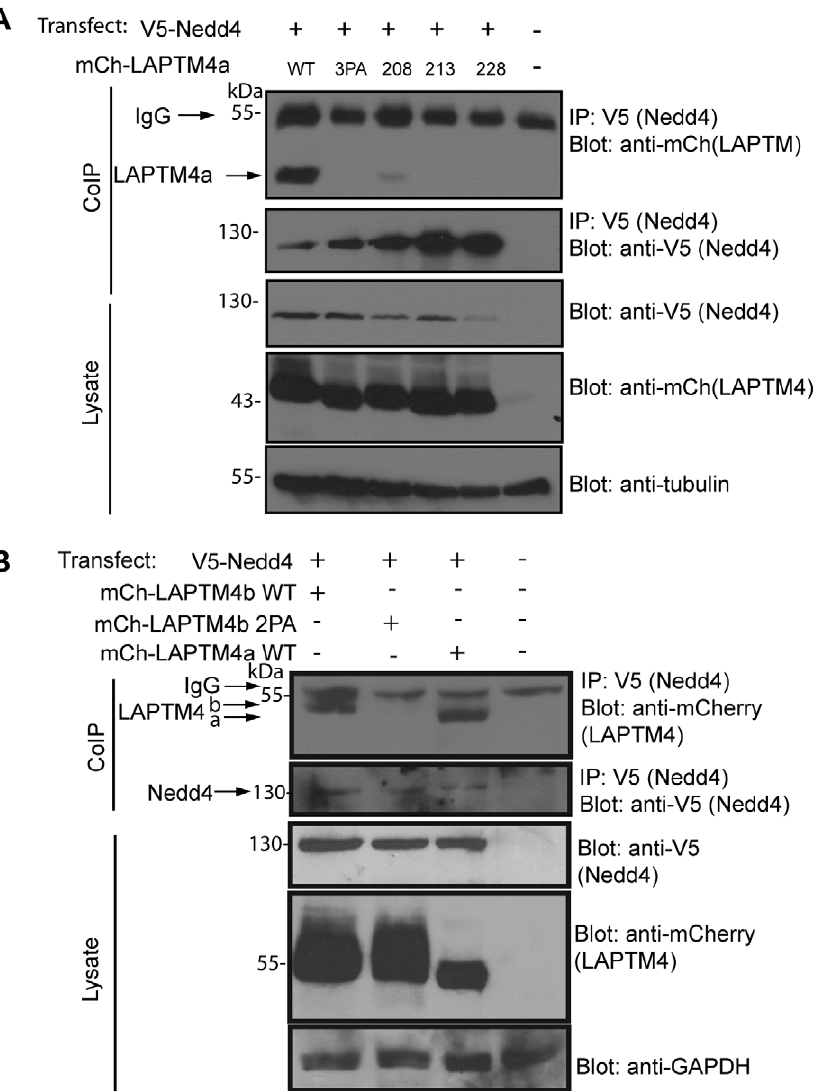
Figure 4. LAPTM4a and LAPTM4b bind Nedd4 via their PY motifs. (A) LAPTM4a’s binding to Nedd4 is dependent on its 2nd and 3rd PY motifs. A Co-IP was performed on whole cell lysates from Hek293T cells co-expressing V5-tagged Nedd4 and mCh-LAPTM4a (WT, 3PA, P208A, P213A or P228A). Nedd4 was precipitated using anti-V5 antibodies, samples were separated on SDS-PAGE and transferred to nitrocellulose. Anti-mCherry antibodies were used to detect binding of mCh-LAPTM4s to Nedd4. (B) LAPTM4b binding to Nedd4 is dependent on its PY motifs. A CoIP was performed on whole cell lysates from Hek293T cells co-expressing V5-tagged Nedd4 and mCh-LAPTM4a-WT, mCh-LAPTM4b-WT or mCh-LAPTM4b- 2PA, as in (A).The housekeeping proteins Tubulin and GAPDH were used interchangeably as loading controls for the cell lysates. (IgG bands are detected due to the HRP-conjugated 2 o antibody’s specificity for mouse Ig, which detects the Ig heavy and light chains of the V5 antibody used during the